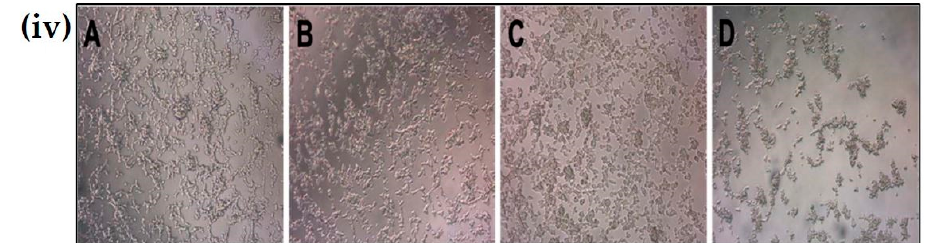
Figure 5. ( i ) Cytotoxicity of chitosan nanoparticles at different concentrations after 24 h of incubation; ( ii ) Protective effect of chitosan nanoparticles against rotenone insult in SH-SY5Y cells; ( iii ) Hoechst-